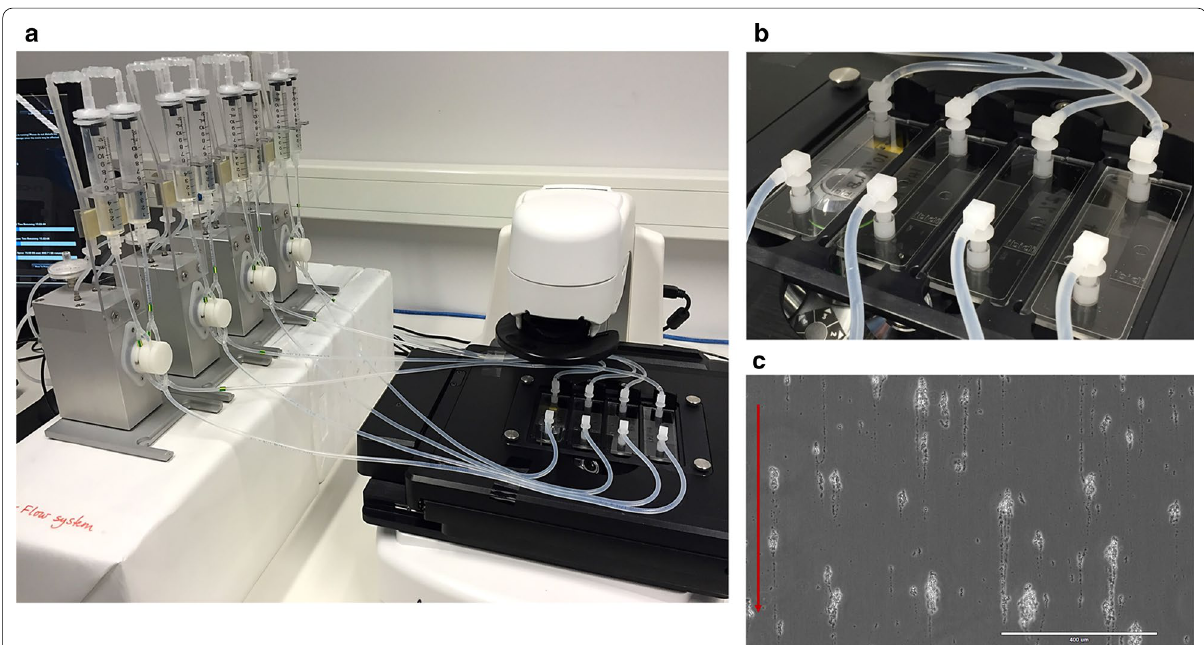
Fig. 1 The Flow cell system. Panel a Fluidic units with syringes (left) connected to µ‑slides mounted in the microscope (right). The syringes are filled with medium that flows continuously over a growth chamber in the µ‑slide. Panel b Close‑up of the four growth chamber µ‑slides. Panel c Micrograph of biofilm structures with a characteristic tail formed in the growth chamber after 20 days of flow, 10 indicates the flow direction. Example from a lignin‑enriched compost biodiversity. Image credit: Gunhild